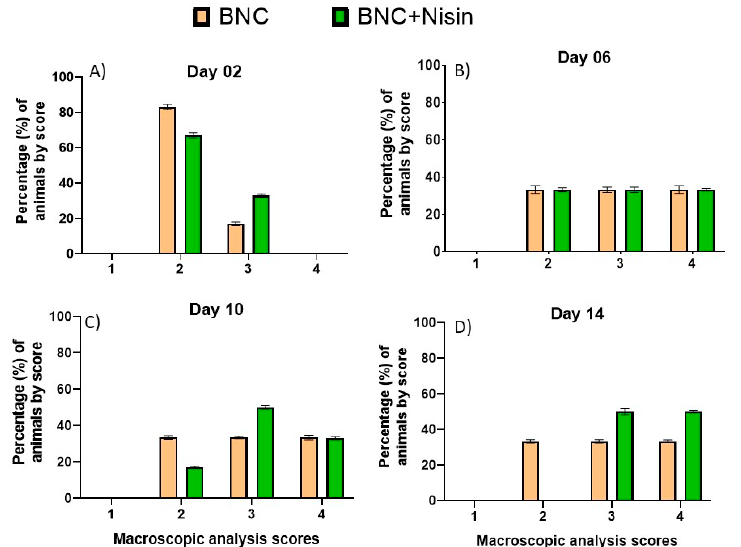
Figure 3. Descriptive macroscopic evaluation of the surgical wounds of animals from Experiment II ( n = 12), by score, at 2 days ( A ), 6 days ( B ), 10 days ( C ) and 14 days ( D ) post-surgery. Scores: 1—Moderate inflammation, no epithelialization; 2—Mild inflammation, initial epithelialization; 3—No inflammation, presence of epithelialization; 4—Hair growth, signs of epithelialization. BNC group = standard treatment + bacterial nanocellulose membrane; BNC+Nisin = standard treatment + Nisin loaded in bacterial nanocellulose membrane.